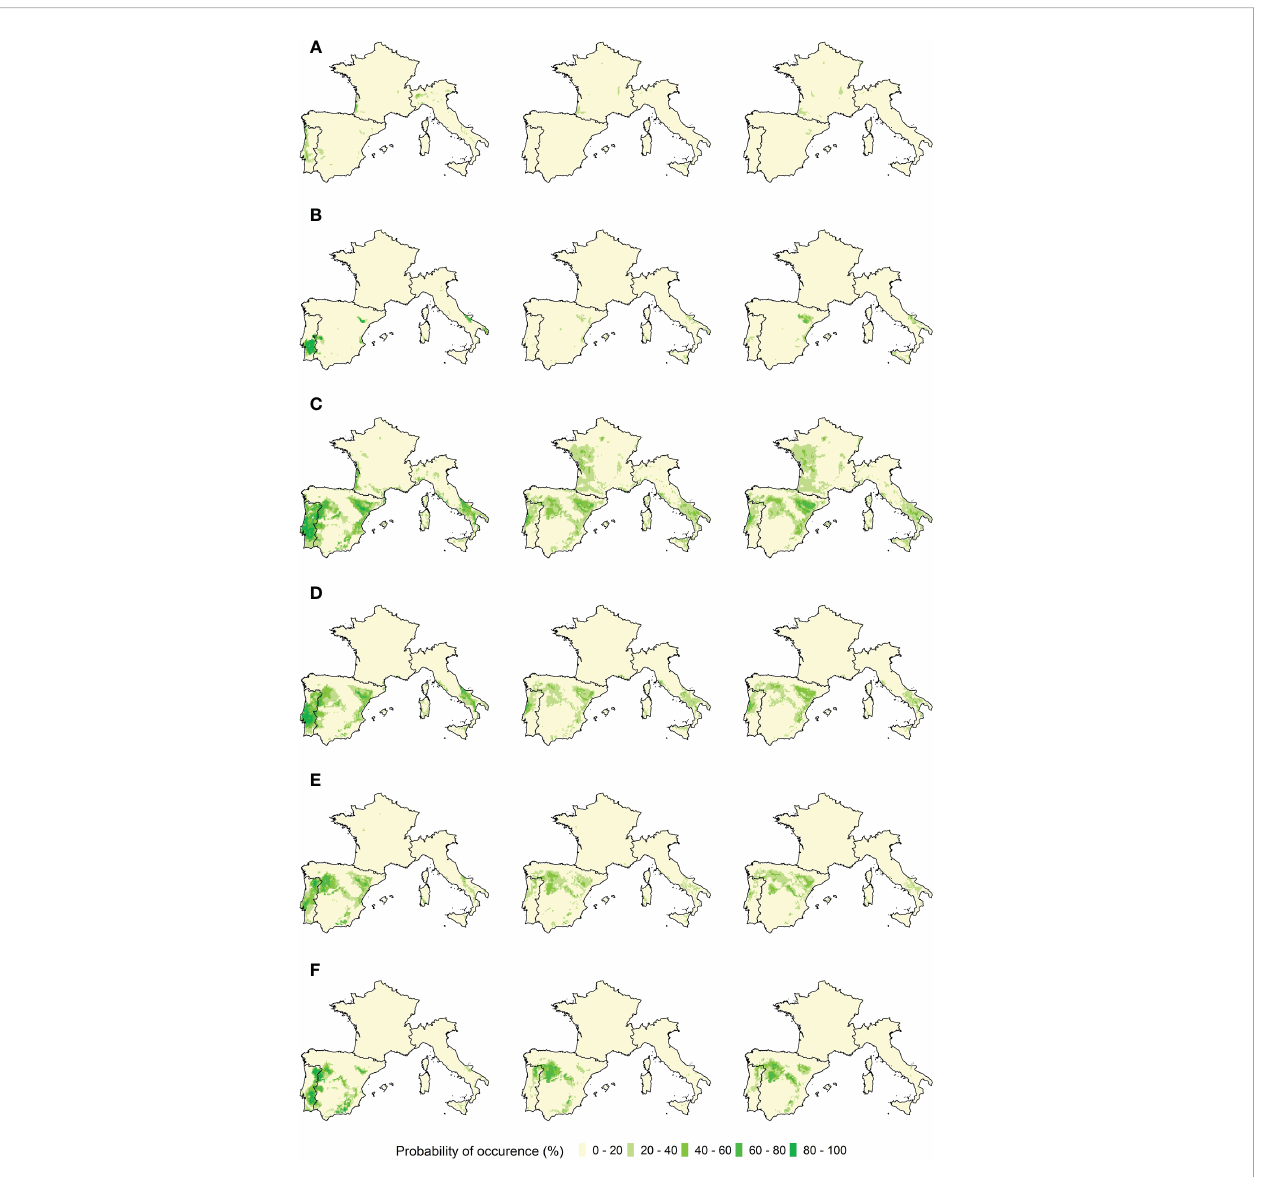
FIGURE 5 Ensemble model projected bioclimatic suitability for white varieties (A) Alvarinho, (B) Antão-Vaz, (C) Arinto, (D) Fernão-Pires, (E) Malvasia-Fina, and (F) S ı ́ ria. Left panels: Recent past distribution of bioclimatic suitability (1989 – 2005). Middle panels: Future bioclimatic suitability projections (2021 – 2050), under the RCP 4.5 climatic scenario. Right panels: Future bioclimatic suitability projections (2021 – 2050), under the RCP 8.5 climatic